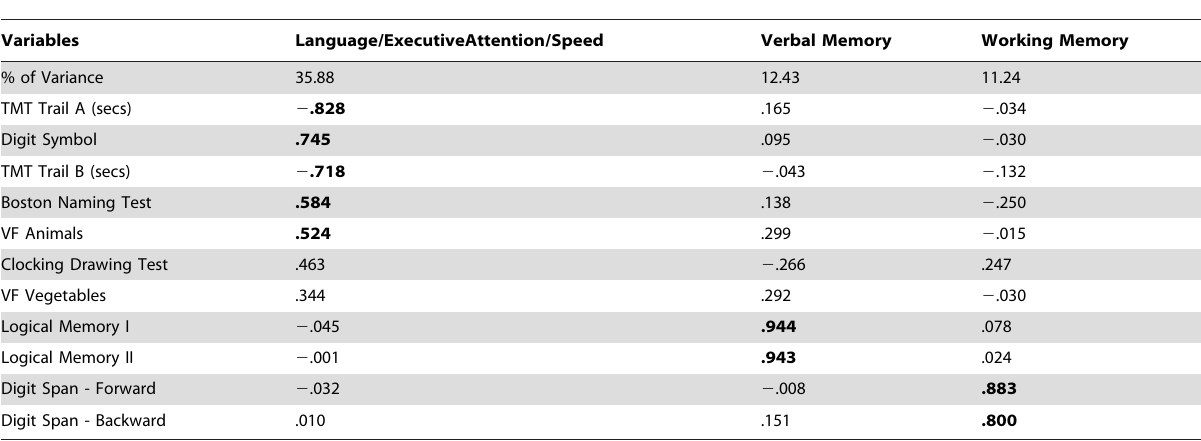
Table 3. Results of the Principal Components Factor Analysis at Year Two.